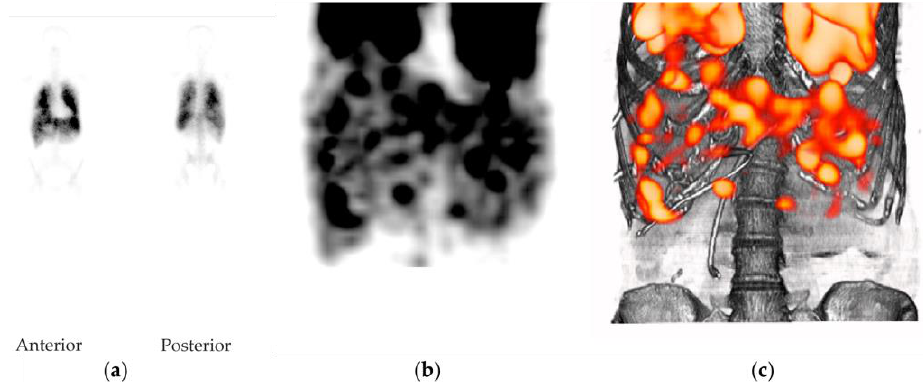
Figure A1. ( a ) PET/CT liver axial image of a patient with liver metastases of colorectal cancer (Au- gust, 2021) showing a necrotic mass without metabolic activity (approximate size of 6 cm on its major axis). ( b – f ) Different CT images of the patient acquired in November 2021. Observe the he- patomegaly progression, the presence of different bilomas, and dilatation of the intrahepatic bile ducts.